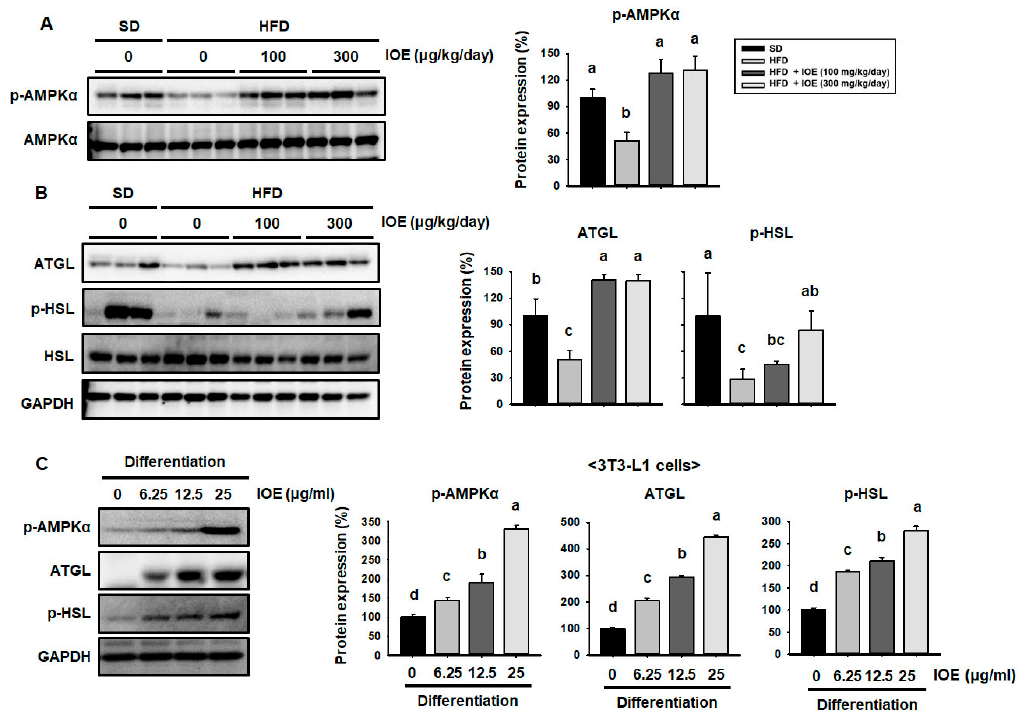
Figure 4. IOE treatment increases phosphorylation of AMPK α and the expression of lipolytic enzymes in 3T3-L1 adipocytes and the WAT of HFD-induced obese mice. Western blotting for AMPK α ( A ) and lipolytic enzymes (ATGL and HSL) ( B ) in WAT. ( C ) Protein expression of AMPK α , ATGL, and HSL in 3T3-L1 adipocytes after differentiation for 8 days. Data are expressed as mean ± SD ( n = 6). Values with different letters are significantly different; p < 0.05 (a > b > c > d).